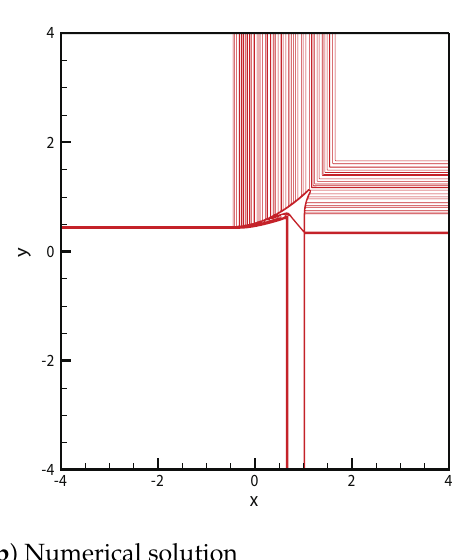
u 2 1 + u 2 3 − 2 u 1 u 4 u 3 − u